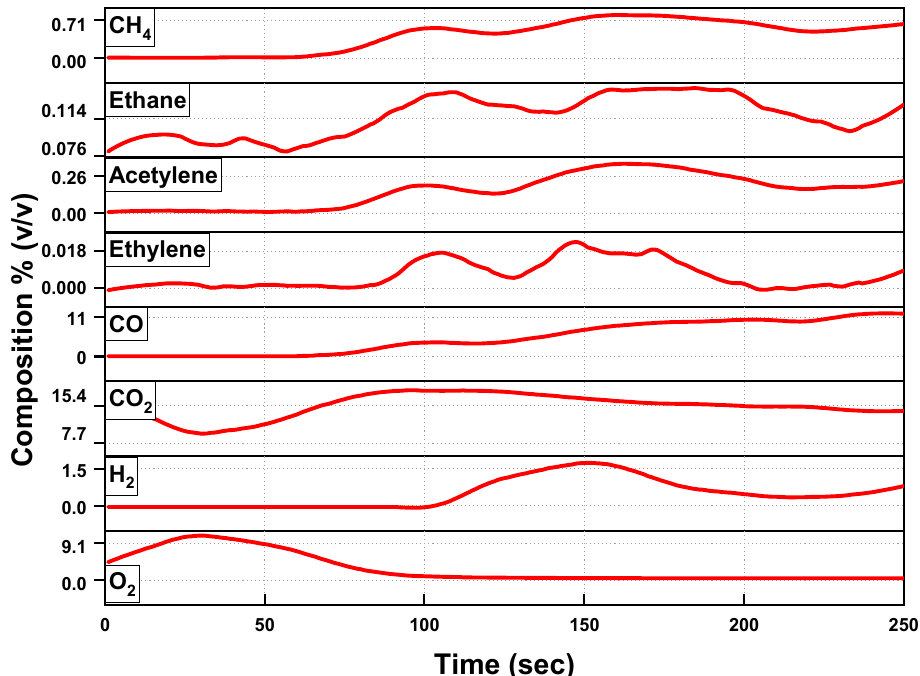
Figure 6. Evolved components in the gas composition from the gasification of flame retardant cotton pellets after flame retardant removal.